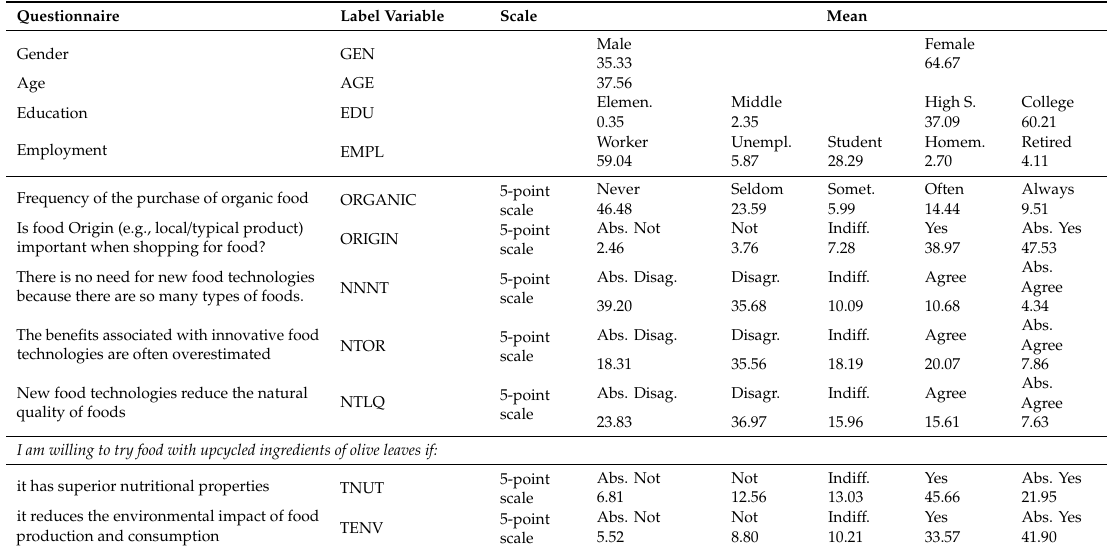
Table 1. Questionnaire and descriptive statistics of variables ( n =